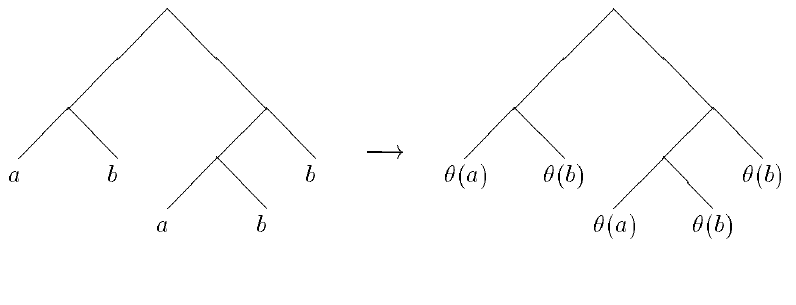
Fig. 1: Computing the image of